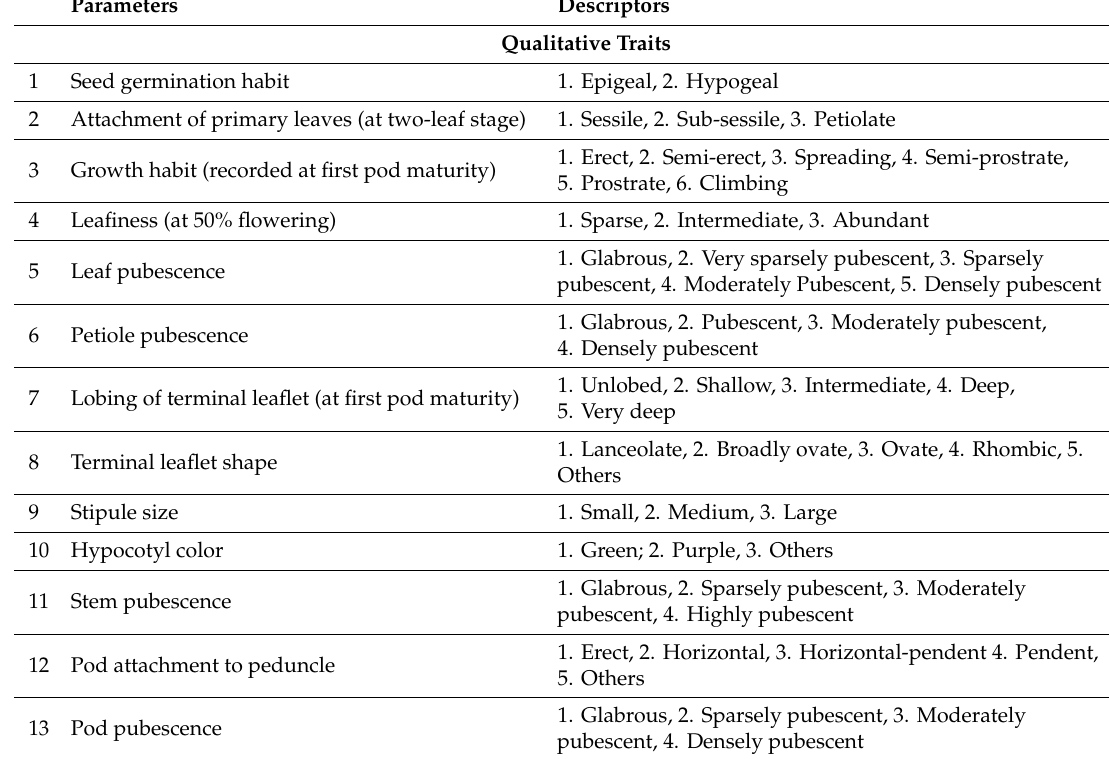
Table 1. Important descriptors for the characterization of the wild Vigna species germplasm